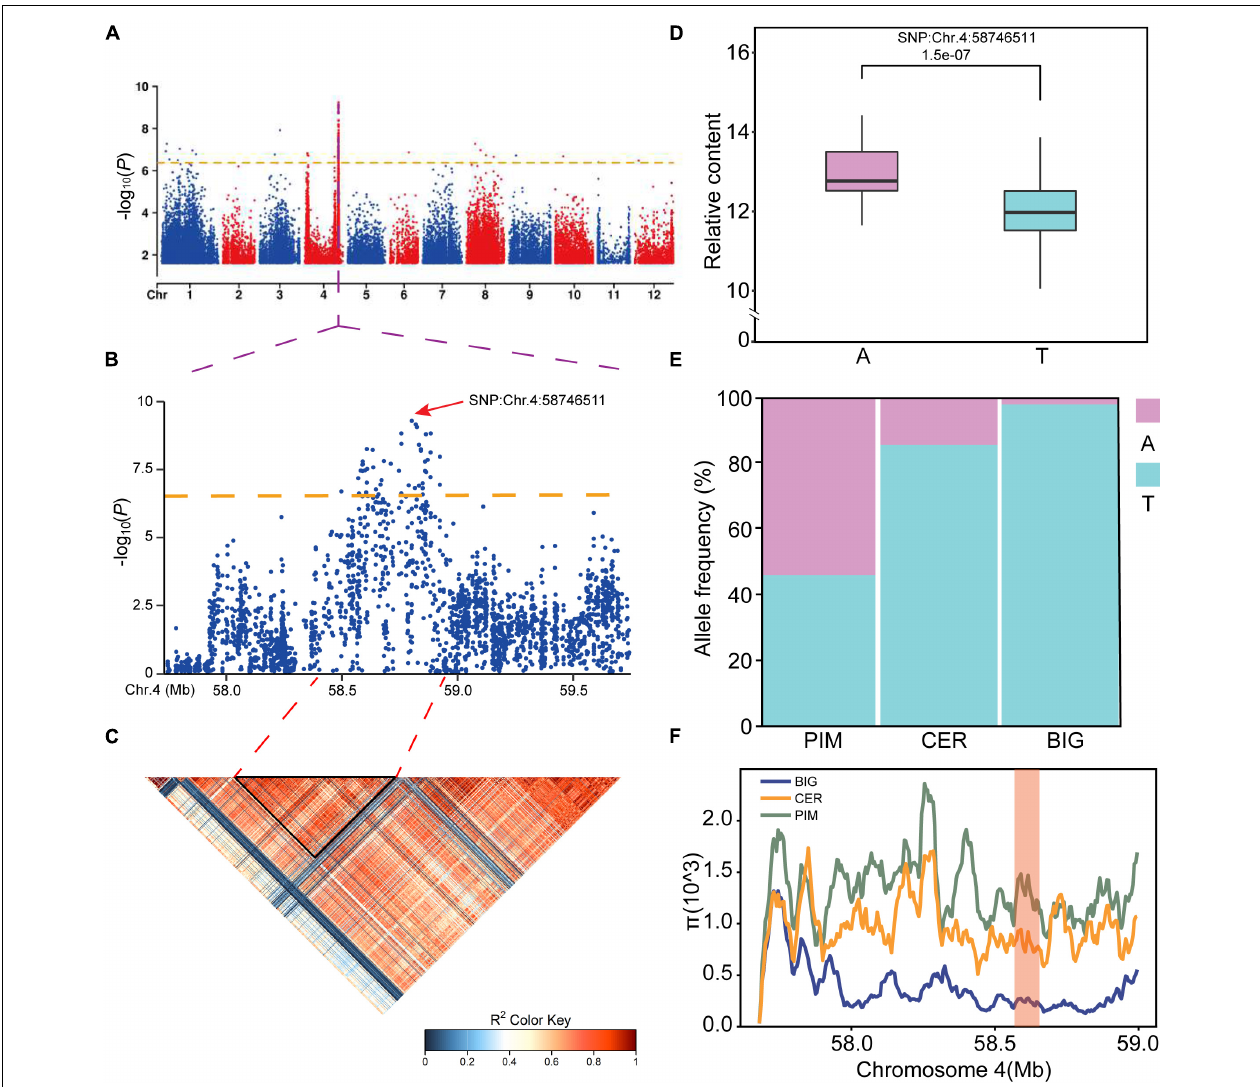
FIGURE 3 | Assignment of the putative causative gene of the natural variation in esculeoside A content. (A) Genome-wide association study (GWAS) of esculeoside A content. The orange dashed line represents the significance threshold ( p = 4.19E–7). Region Manhattan plot (B) and linkage disequilibrium (LD) heatmap (bottom) (C) surrounding the peak on chromosome 4. (D) Box plot for the normalization content by log 2 of esculeoside A plotted as a haplotype, Chr.4:58746511. (E) The allele distribution of varieties containing A or T allele among tomato subpopulations. (F) The causative locus is located within a sweep region with much lower nucleotide diversity in BIG than in either CER or PIM. The red column represents the region around SlERF.D6